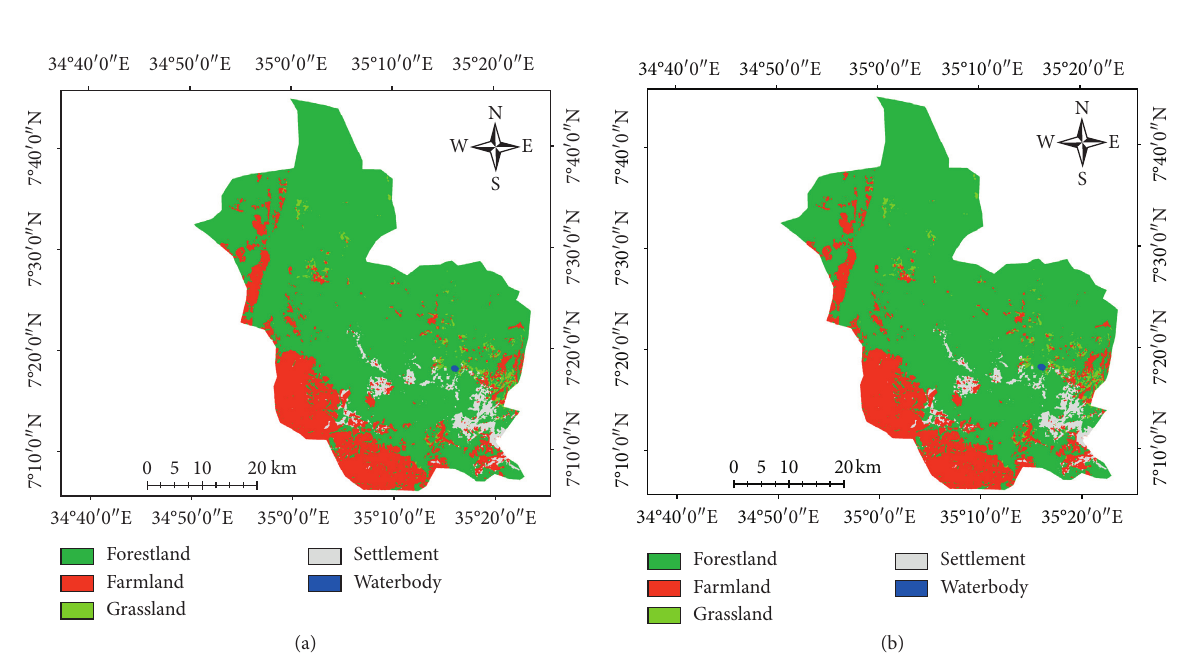
Figure 6: The actual (a) and simulated (b) LULC maps of MFBR for